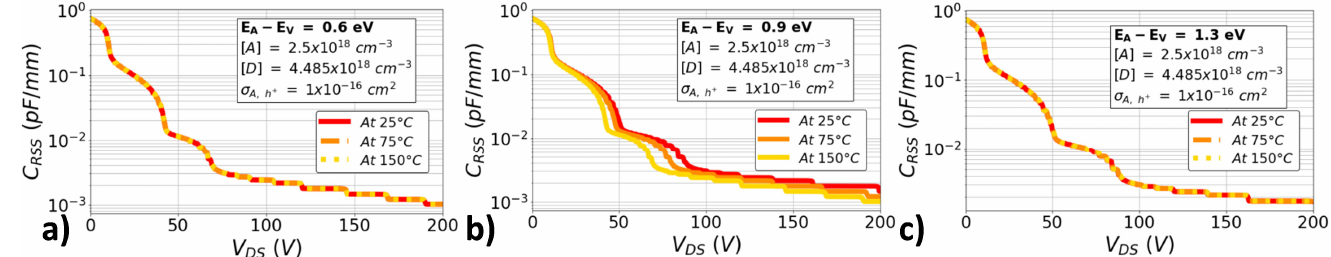
Figure 5. Simulated C RSS (V DS ) temperature for different acceptor trap energy: ( a ) 0.6 eV (Split 1) ( b ) 0.9 eV (Split 2) ( c ) 1.3 eV (Split